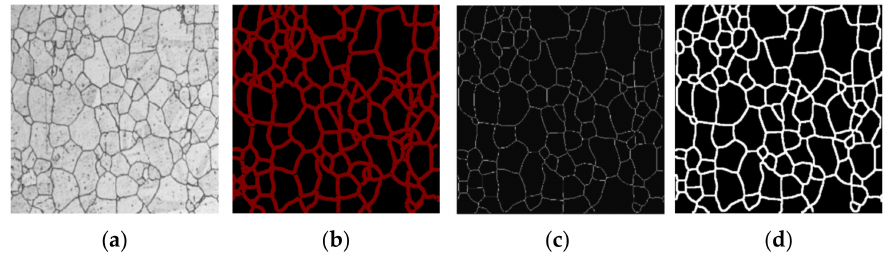
Figure 3. Process of image annotation. ( a ) Original image; ( b ) annotated image; ( c ) single-pixel skeleton image; ( d ) bolded